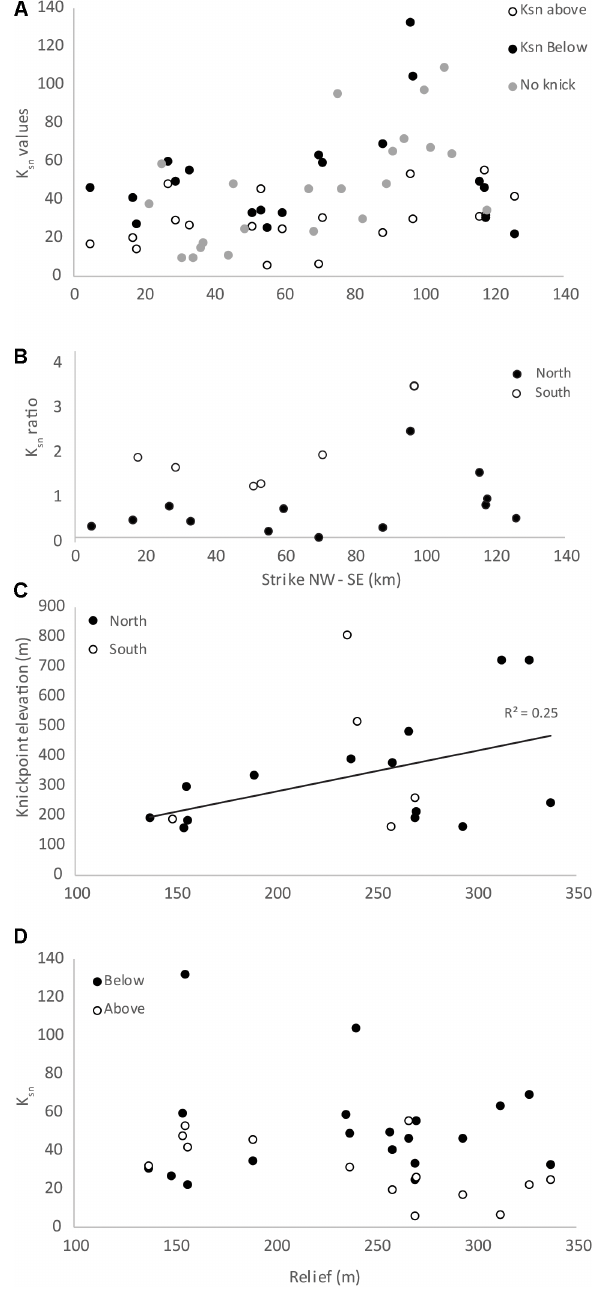
for Guadalcanal using k sn for the rivers without knickpoints, assuming U = E and n = 1, deriving values of K in the range 1 × 10 − 5 – 5 × 10 − 8 m 0 . 1 yr − 1 . The spread of values likely reflect a combination of factors that are difficult to